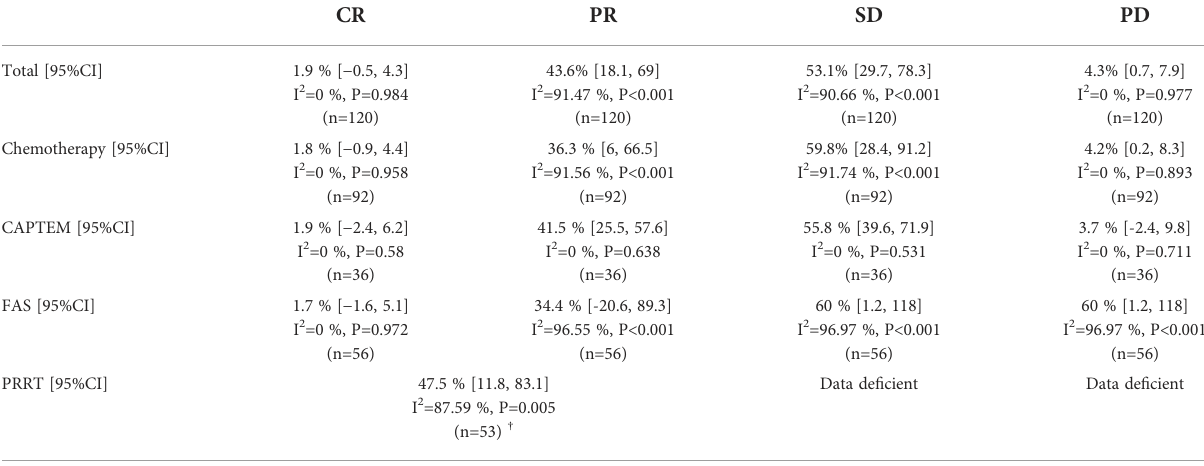
TABLE 2 Estimate of tumor response after neoadjuvant therapy between different therapy